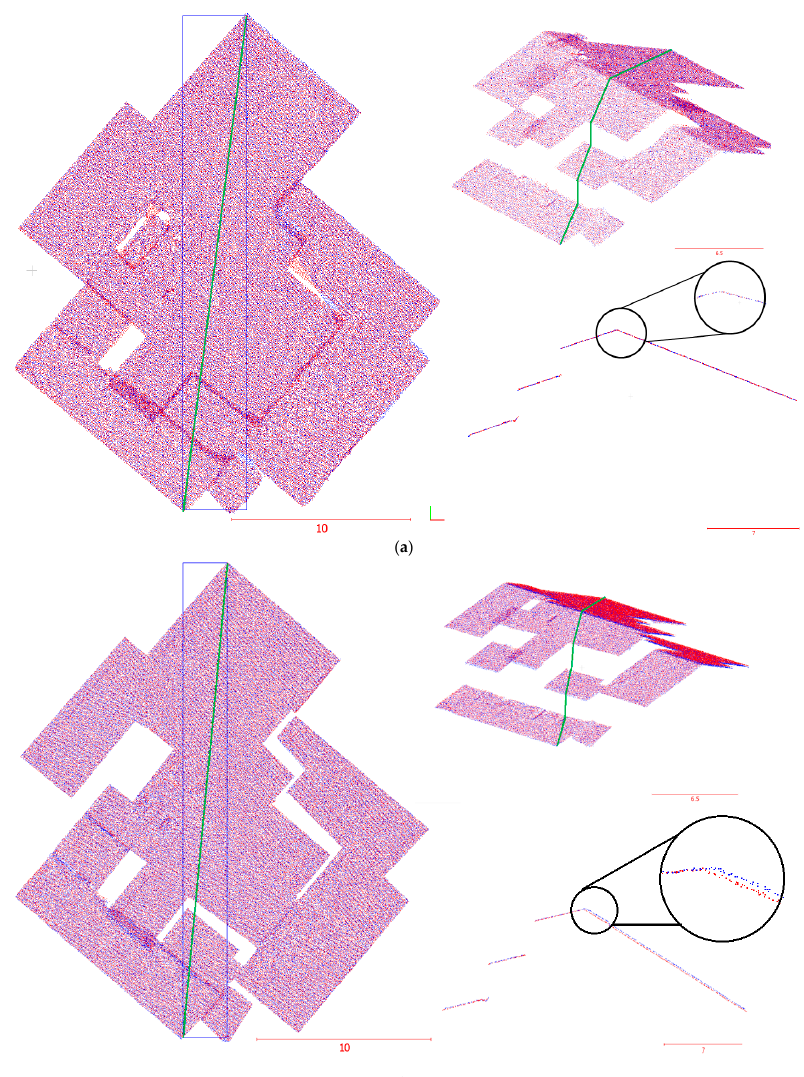
Figure 9. Registration results for a part of the Lethbridge landslide area. ( a ) Results based on the proposed registration method; ( b ) results based on the iterative closest projected point (ICPP)-based registration method.